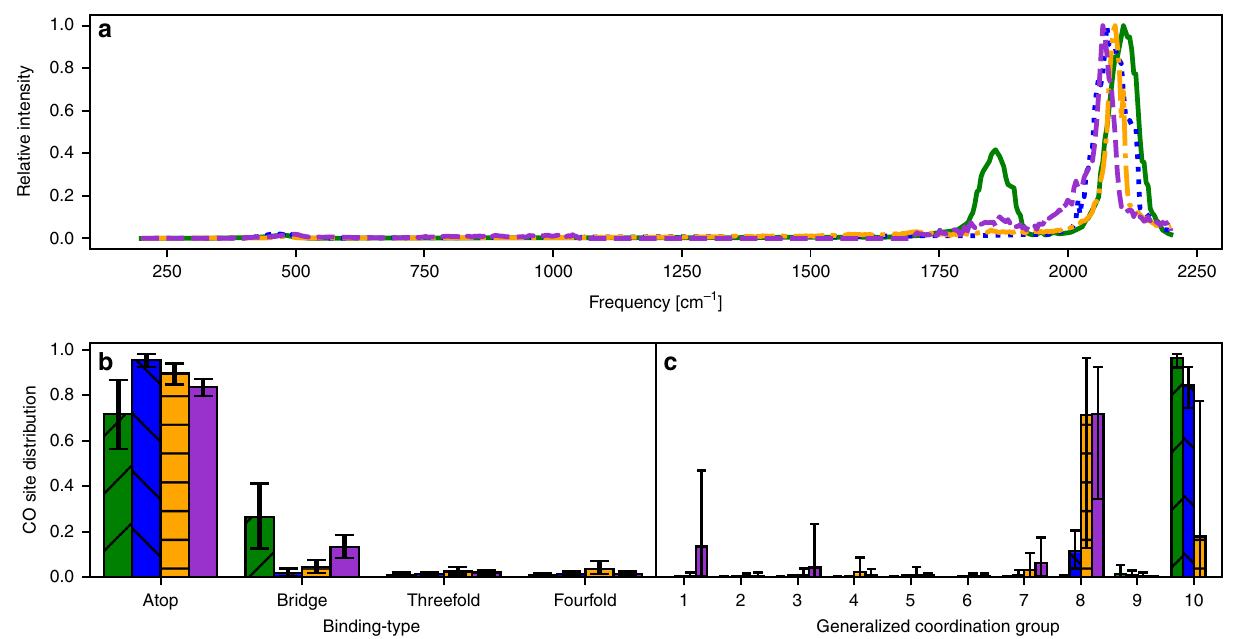
Fig. 6 Experimental literature HREEL and SERS spectra for CO on platinum, converted to IR spectra, and predicted microstructure. a Discretized experimental spectra. b / c Inverse machine learning model predictions for types and environments of sites. GCN data is binned into groups of GCN ranges: group 1 (0 – 1.8), 2 (1.8 – 2.8), 3 (2.8 – 3.7), 4 (3.7 – 4.5), 5 (4.5 – 5.2), 6 (5.2 – 6.1), 7 (6.1 – 7.0), 8 (7.0 – 7.9), 9 (7.9 – 8.5) and 10 (high coverage low-index planes). Spectra and predictions are for CO on Pt(111) at 0.5 ML (green solid line and bars with forward slashes ( b , c )), Pt(111) at 0.17 ML (blue dotted line and bars with backslashes ( b , c )), Pt(110) at 1 ML (yellow dashed-dotted line and bars with horizontal lines ( b , c )), and Au/Pt core/shell nanoparticles at low coverage (purple dashed line and solid bars ( b , c )). An ensemble of neural networks is used resulting in a distribution of predictions. The colored bars indicate the mean value of the prediction and the black error bars indicate the 95% prediction region.